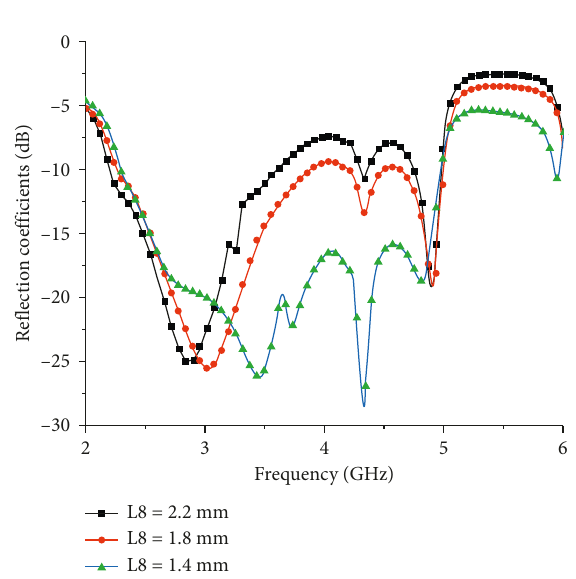
Figure 5: Simulated reflection coefficients of the MIMO antenna for different widths of the printed width